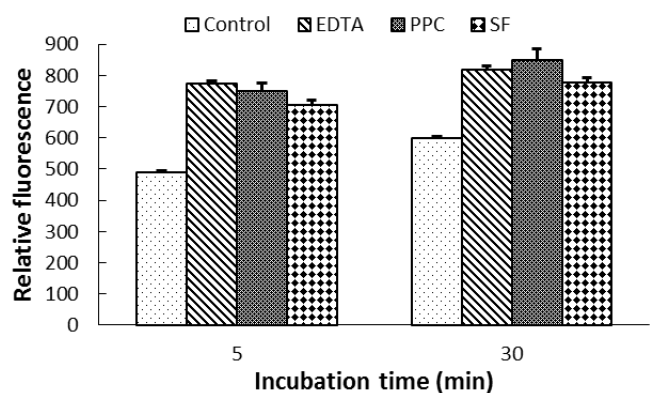
Figure 2. 1- N -Phenylnaphthylamine (NPN) fluorescence of Escherichia coli (ATCC25922) pre-cultured with ethylenediaminetetraacetic acid (EDTA; 0.05µmol/mL) or condensed tannins (10 µg/mL) from purple prairie clover (PPC; Dalea purpurea Vent.) and sainfoin (SF; Onobrychis viciifolia ). Bars indicate standard